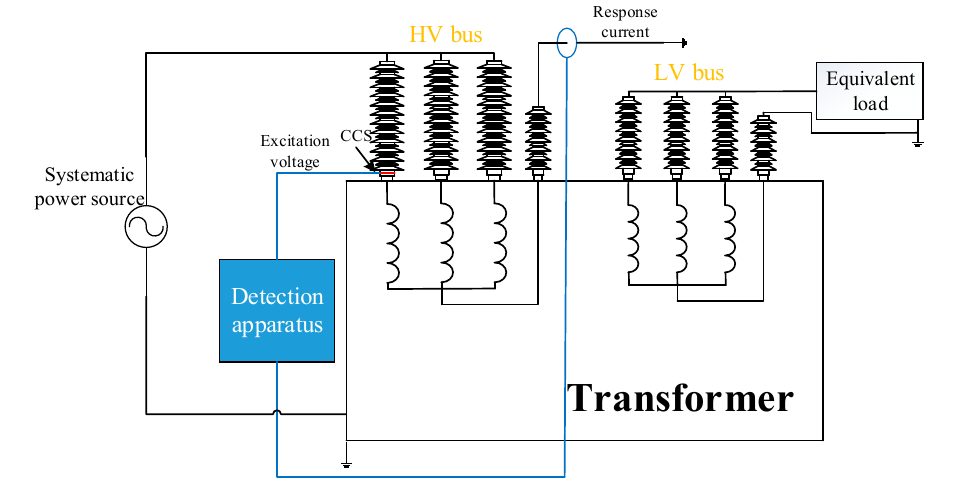
Figure 1. Wring of the online impulse frequency response analysis (IFRA) method applied in a running transformer.